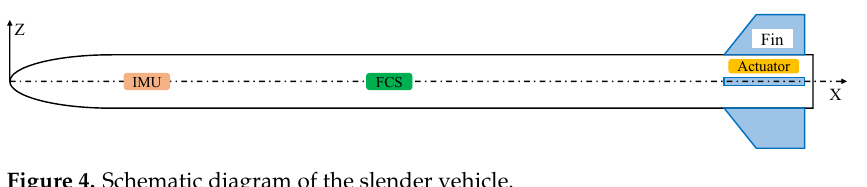
Figure 4. Schematic diagram of the slender vehicle.